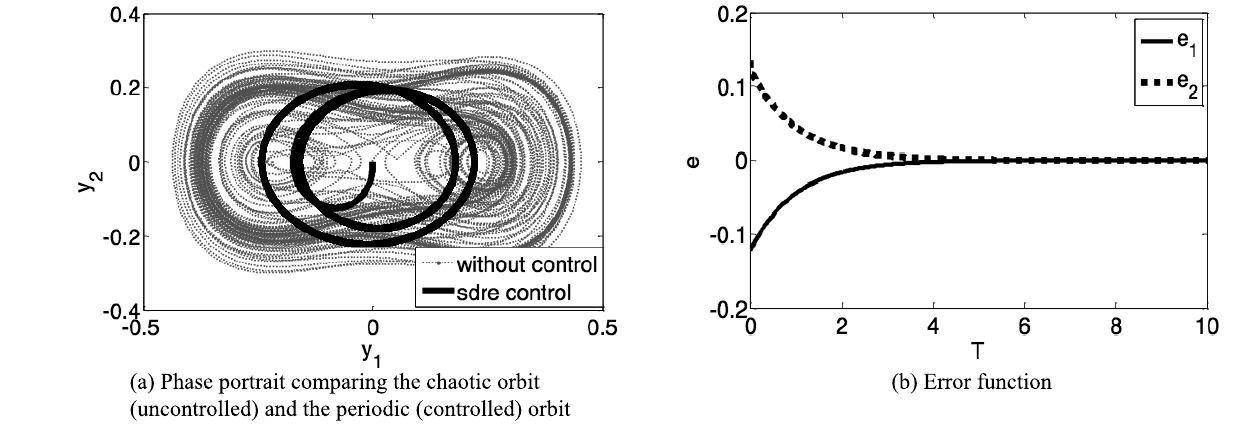
Fig. 4. SDRE simulation